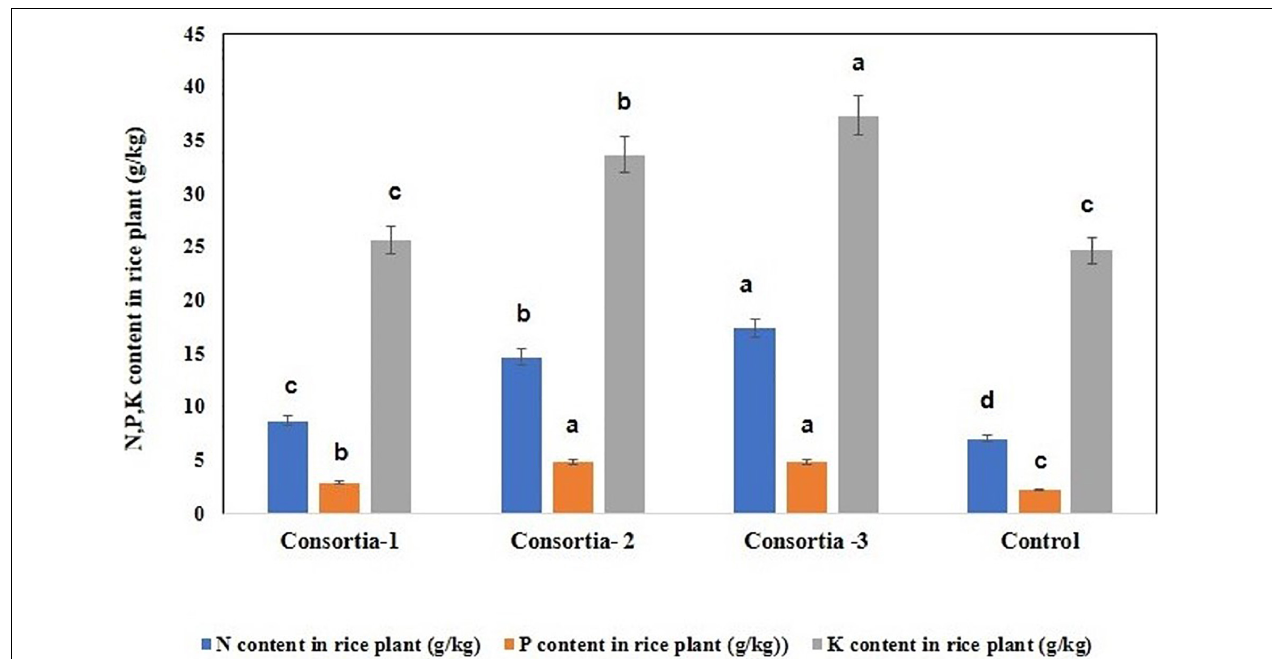
FIGURE 5 | Nitrogen, phosphorus, and potassium uptake for rice plant after consortia application (60 days trail). Values are means ± SE. abcde letters on the bars denote differences on the basis of a t -test ( p < 0.05).